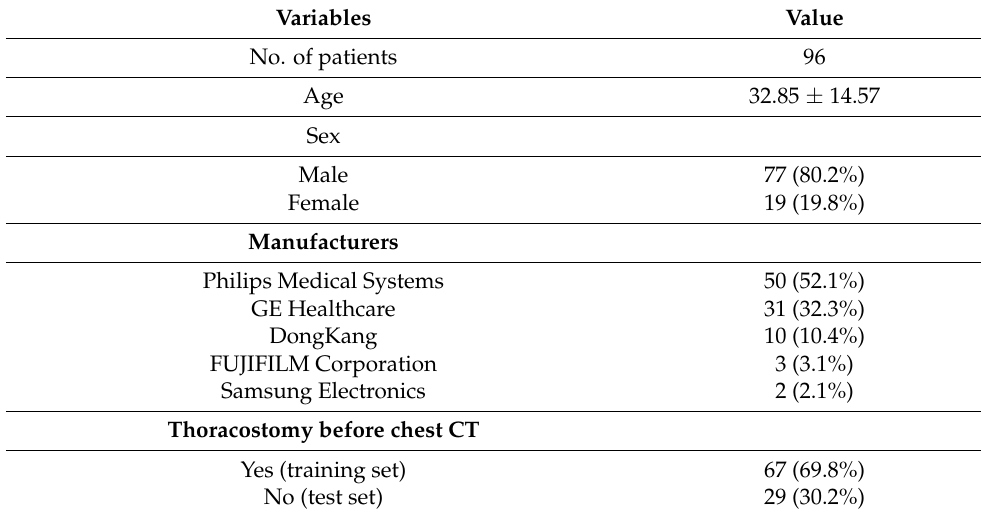
Table 1. Demographic information of the study population.